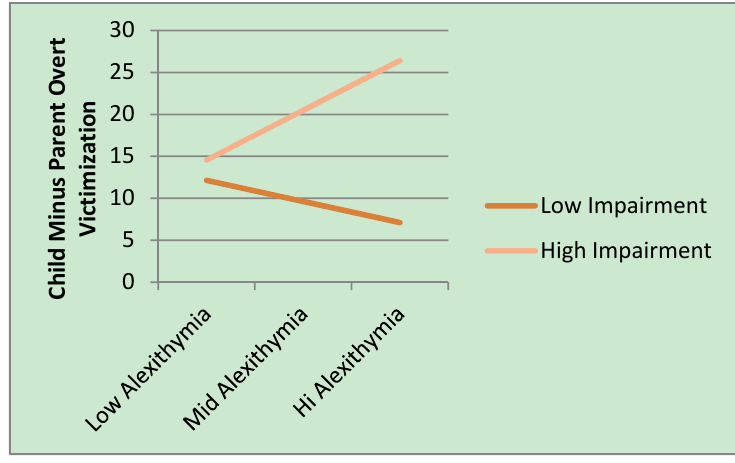
Figure 1. Interaction between TAS difficulty identifying feelings and child reports of perceived impairment from overt victimization as they predict differences in parents’ and children’s overt victimization